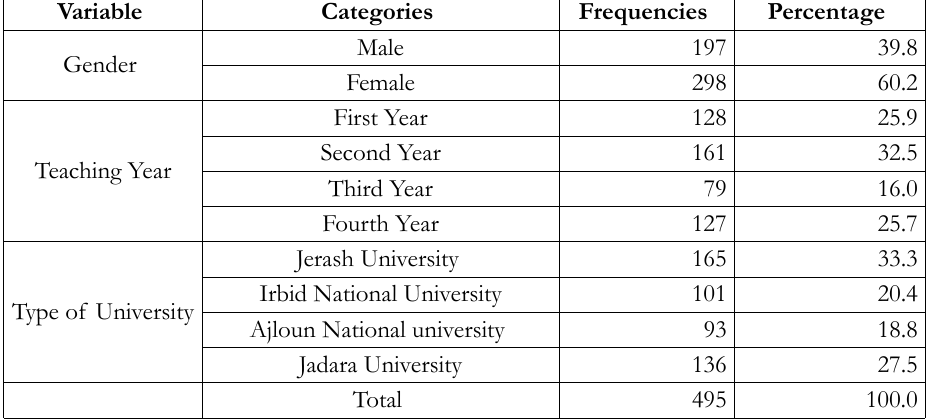
Table 1. Distribution of sample members according to gender, study year and type of